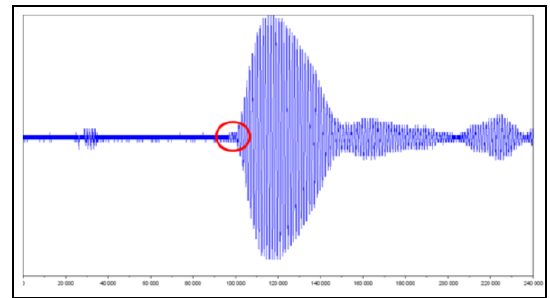
Fig. 10. Determining the beginning of the received signal for accurate flight time determination - a crucial parameter for low measurement uncertainty.